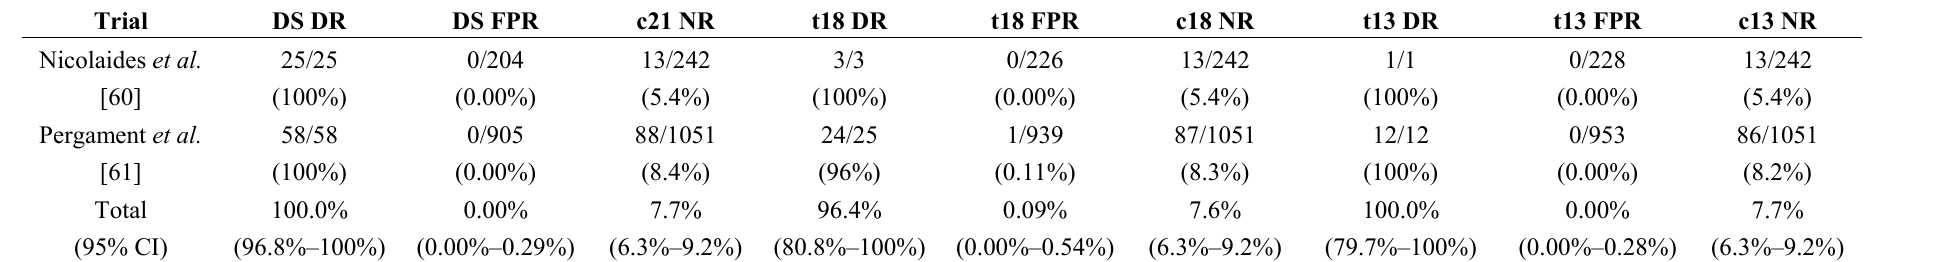
Table 3. Summary data for NIPT or non-mosaic autosomal aneuploidy SNP based